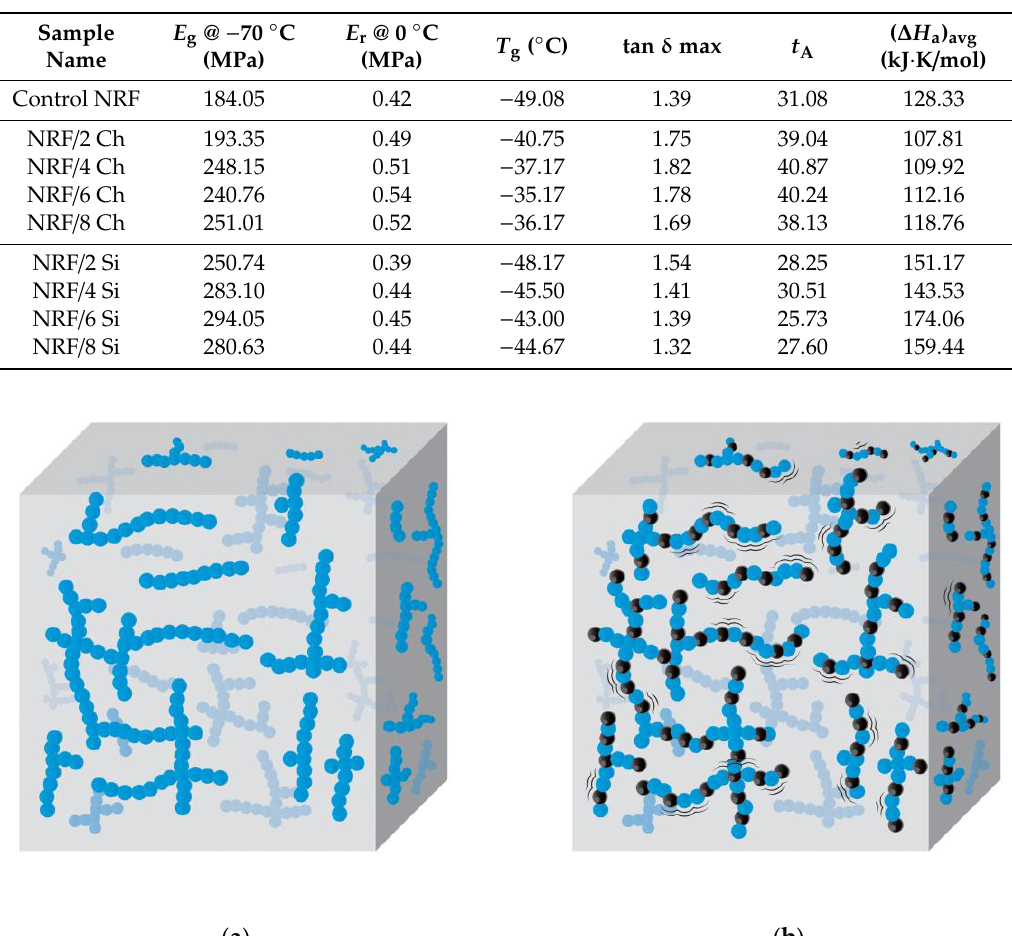
Table 5. Obtained parameters by the dynamic mechanical analysis (DMA) test for the control NRF and NRF with various fillers.